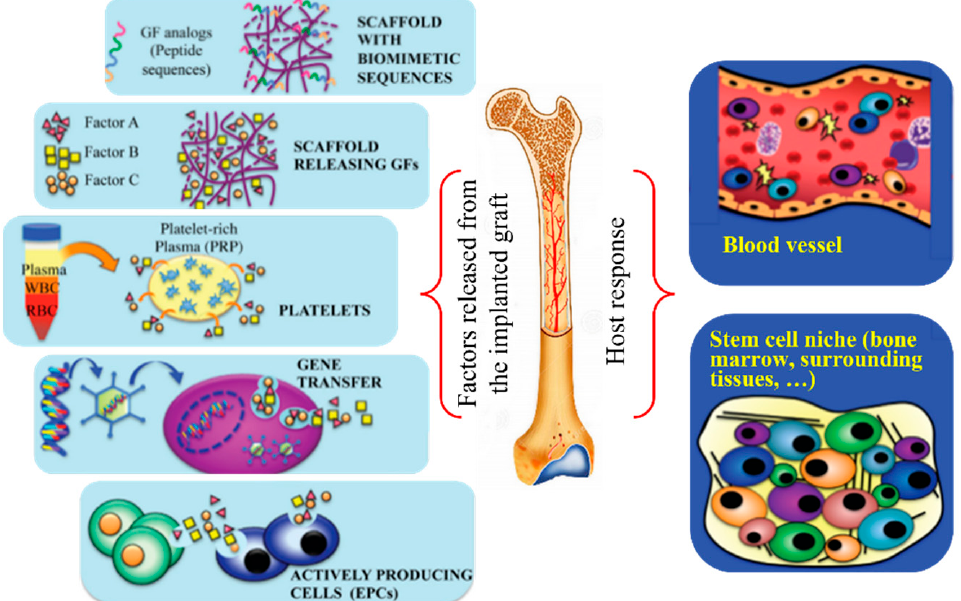
Figure 1. Scheme showing features from implants at the bone defect site that influence the host response. These may include growth factors (or their analogues) released from scaffolds or platelet- enriched plasma-seeded materials, or growth factors released from natural or genetically modified housing cells. In response, cell homing, enhanced vascularization, and bone regeneration will occur. Adapted from [4].